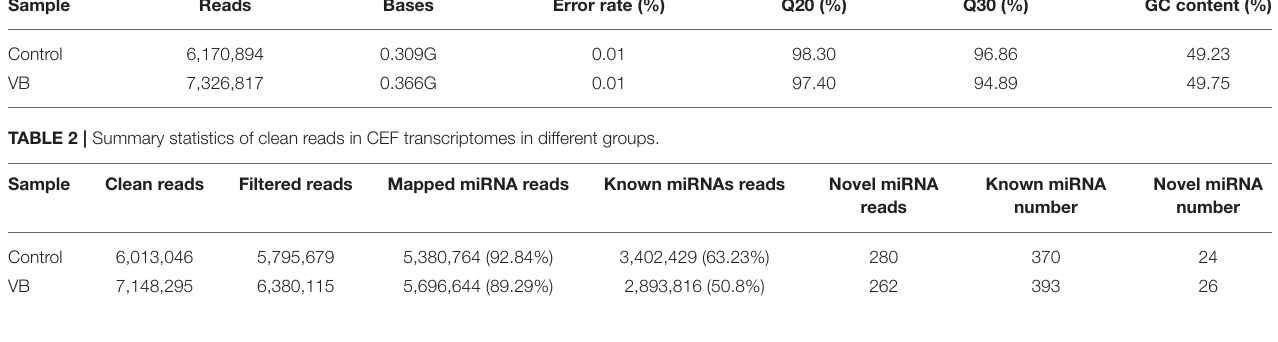
TABLE 1 | Quality evaluation of raw reads. Sample